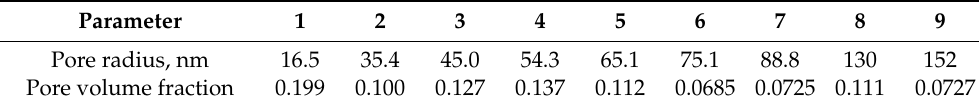
Table 2. Parameters of the stepwise PSD in Figure 3.